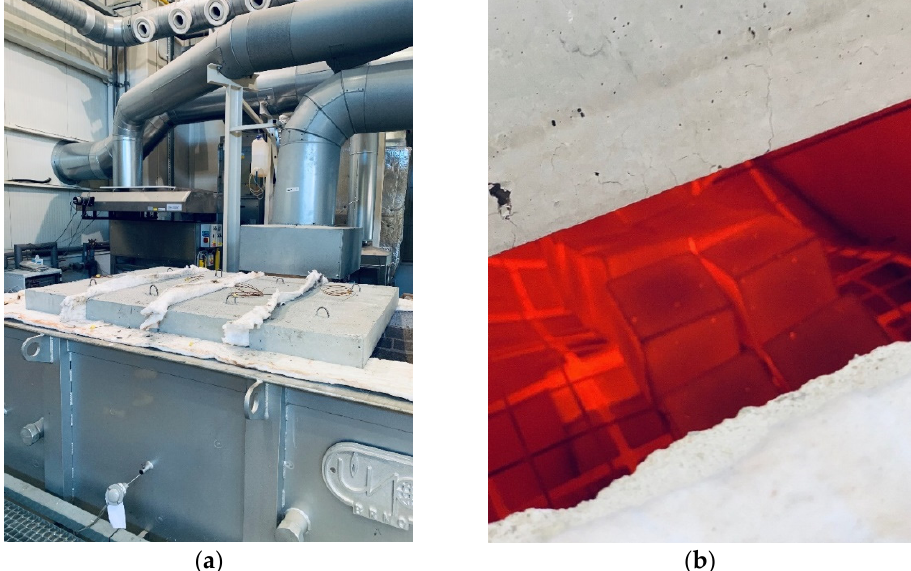
Figure 3. ( a ) View of the furnace system; ( b ) view of the furnace at a temperature load of 1000 °C.